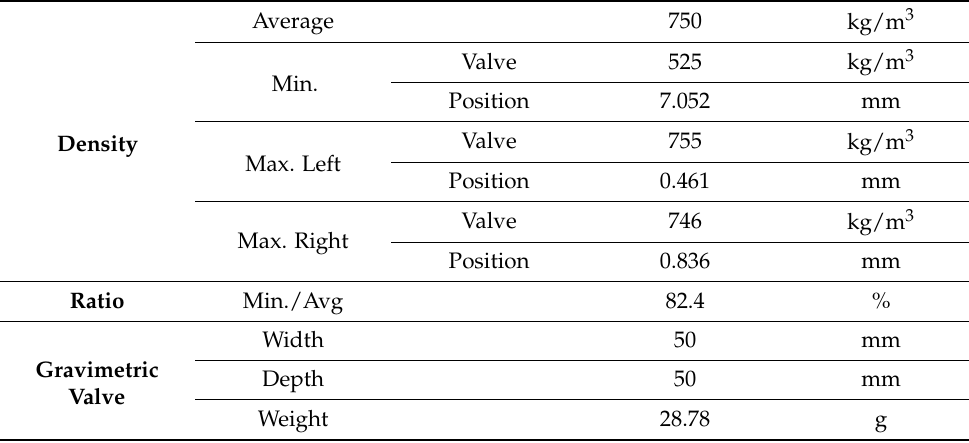
Table 19. Experimental data of 4thsample.